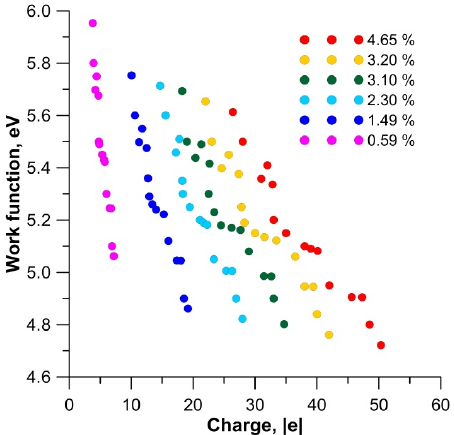
Figure 5. The change in the work function of the film with an increase in charge on the carbon framework for various cases of filling the nanopores with potassium. framework for various cases of filling the nanopores with